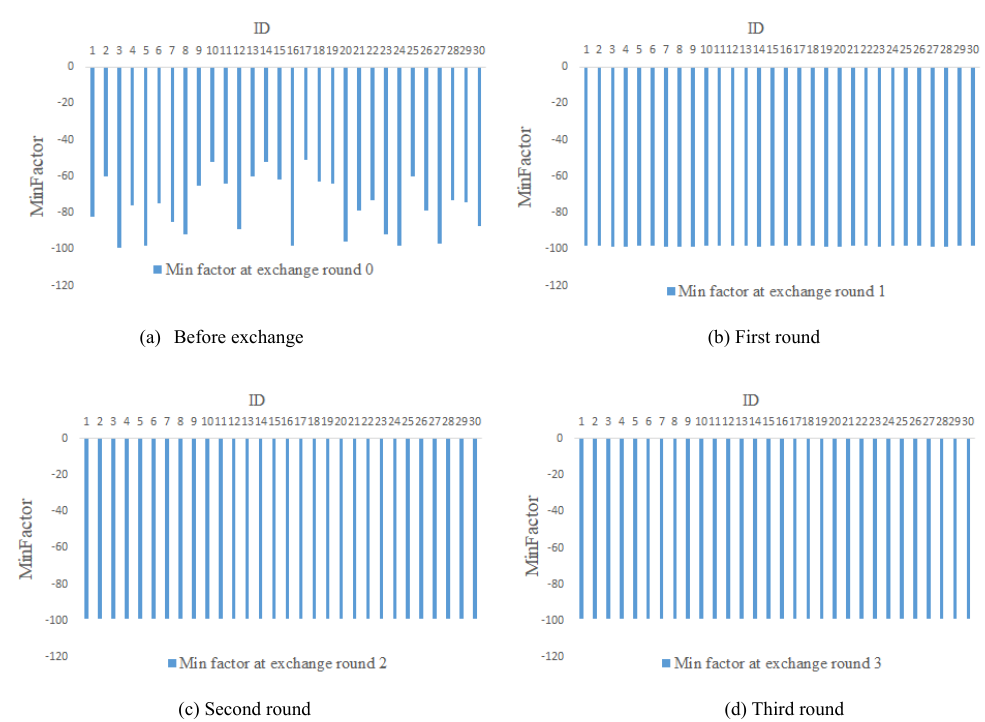
Figure 13. MinFactor at each vehicle in each exchange round in Scenario